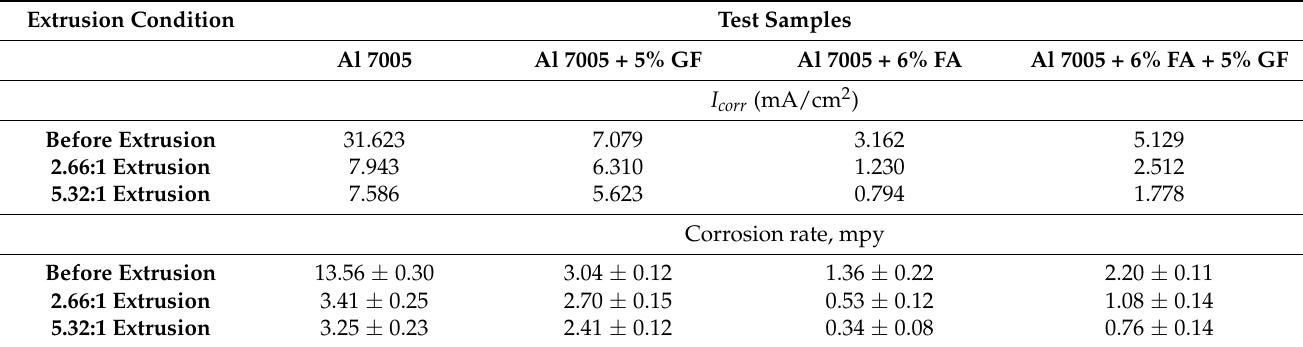
Table 3. Icor and corrosion rate of extruded and non-extruded Al